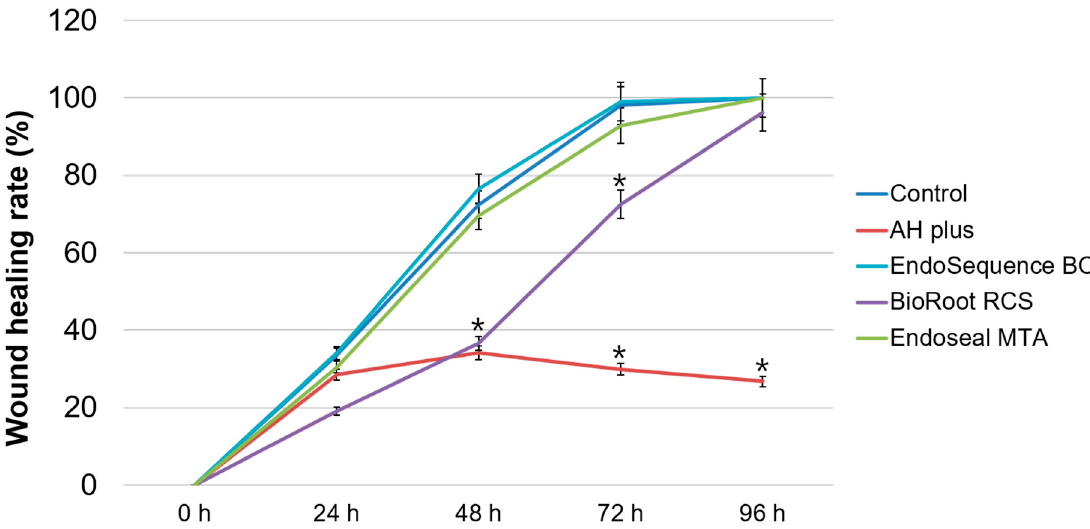
Figure 3. Relative wound healing rate based on the cell migration assay. Asterisks indicate statistically significant differences between the control group and experimental groups.